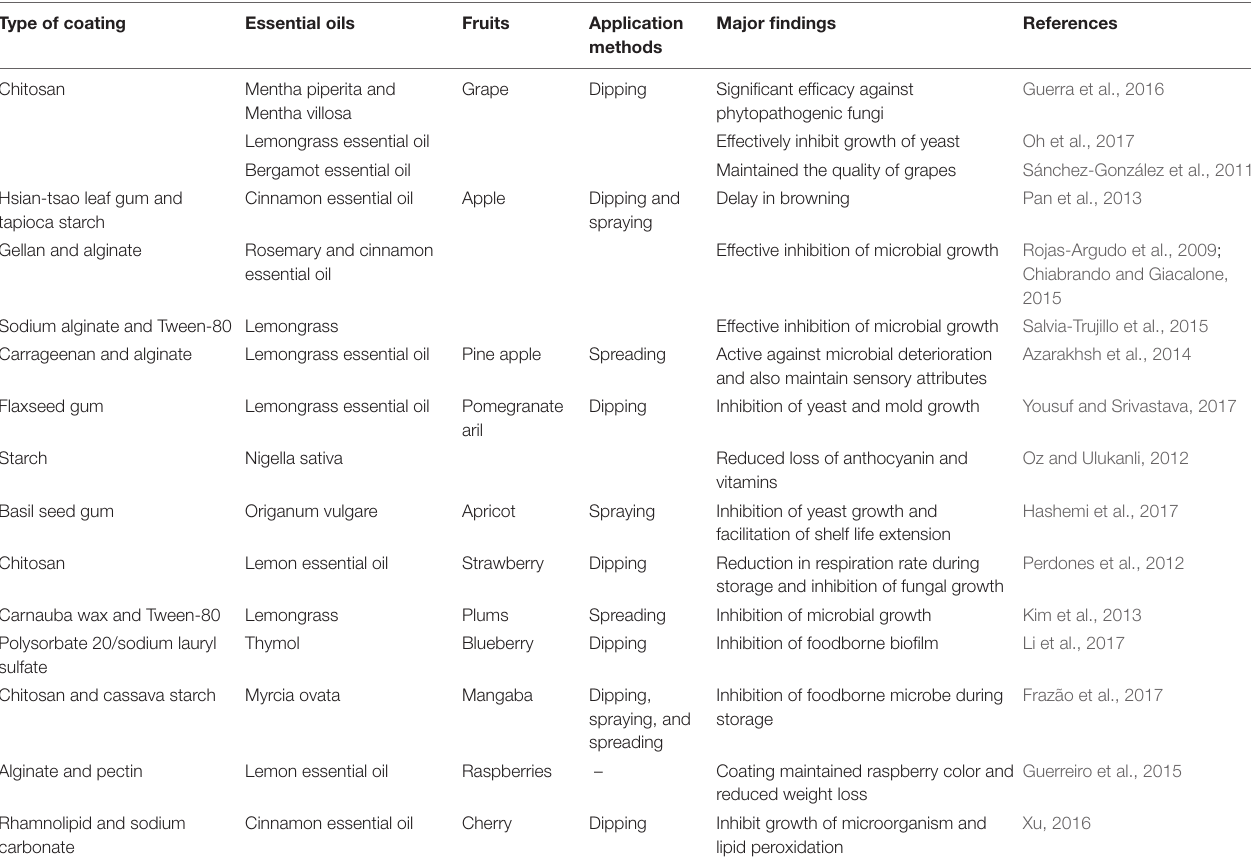
TABLE 1 | Essential oil-based nanoemulsion edible coating of different fruits by using different coating wall polymer and their effects against microbial